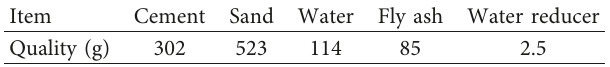
Table 1: Mix ratio of self-compacting cement